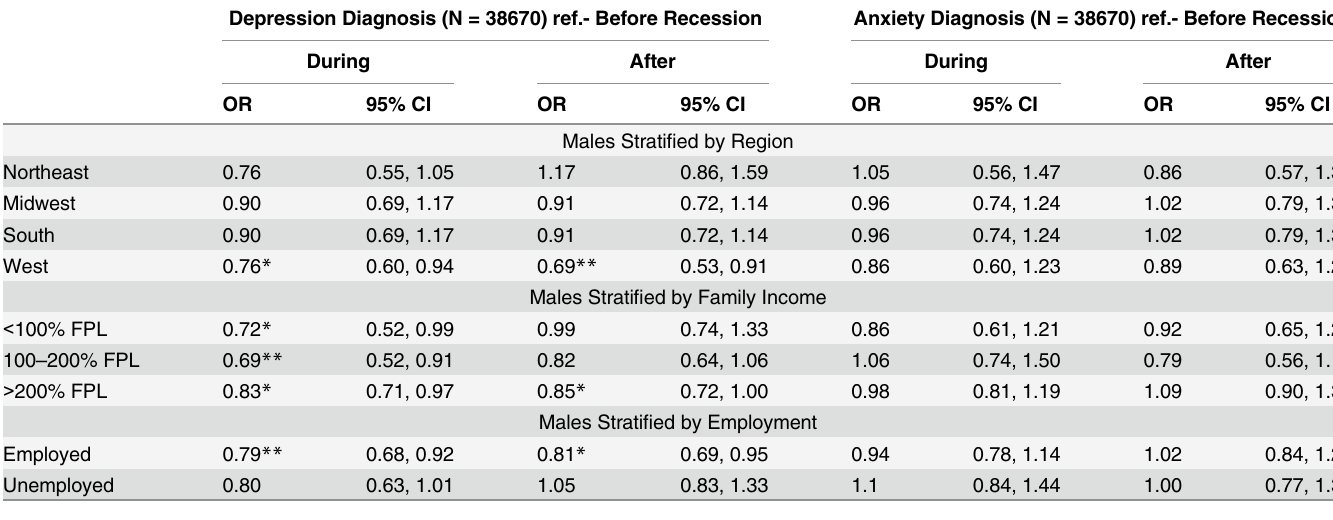
Males Strati fi ed by Employment